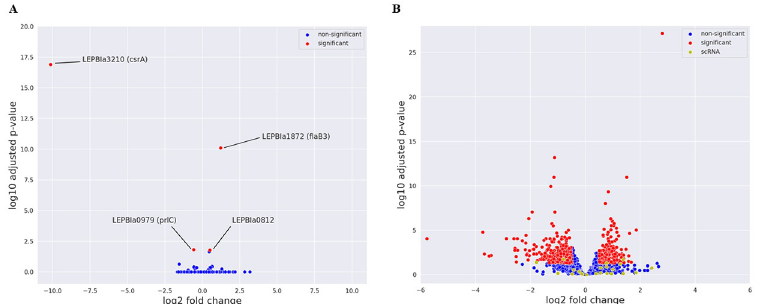
Fig 4. RNA-sequencing. The up- and downregulated genes in Δ csrA or Δ csrA +pMaORI_P csrA are shown in the Volcano analysis. (A) Comparison between Δ csrA and WT and (B) Comparison between Δ csrA +pMaORI_P csrA and WT. Red dots indicated up- or downregulated genes with log2FC > ± 0.5 and adjusted p-value lb (padj) < 0.05. Representative genes are labeled. Blue and yellow dots indicate non-differentially expressed genes and scRNA,